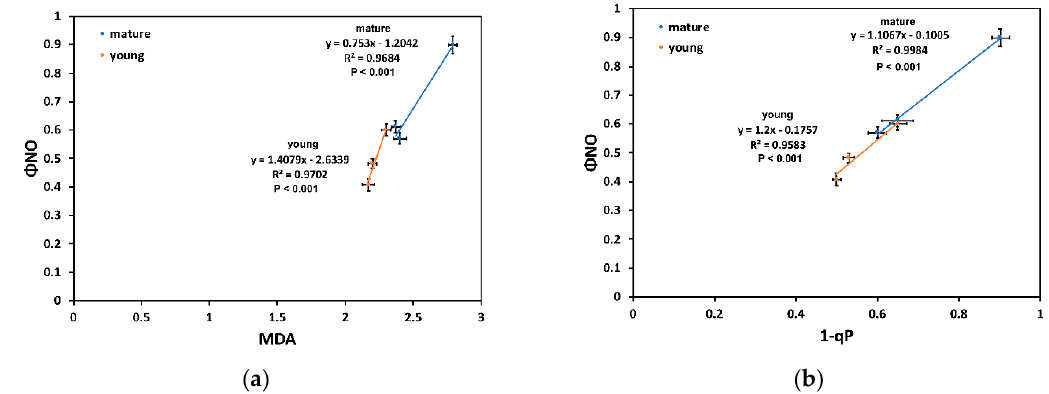
Figure 6. The relationship between the quantum yield of non-regulated energy dissipated in PSII ( Φ NO ) and the level of MDA) ( a ) and the level of excitation pressure (1 − q p ) with Φ NO ( b ), in both YL and ML, at the three DS treatments. Error bars represent ± standard error of the mean (n = 5–6).